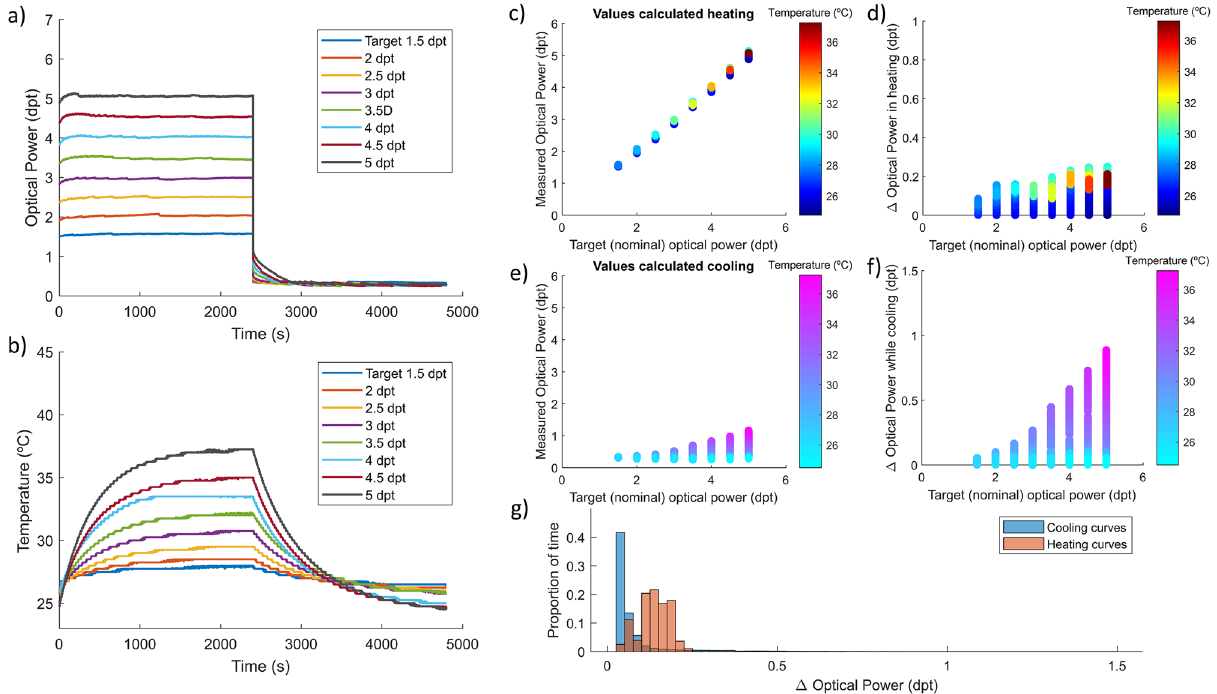
Figure 3. Polynomial model compensation of temperature effect in a TL during long static states of different optical power. ( a ) Graphical description of the result of compensation strategy showing the optical power stabilization in time. ( b ) Internal temperature profile of the lens during the experiment with different target power states. Measured optical power of the lens while heating ( c ) with different driving signals and cooling ( e ) at rest state. Estimated deviation calculated from the difference between target power and measured optical power in the heating ( d ) and cooling ( f ) processes. ( g ) Histogram of optical power deviation while heating (red) and cooling